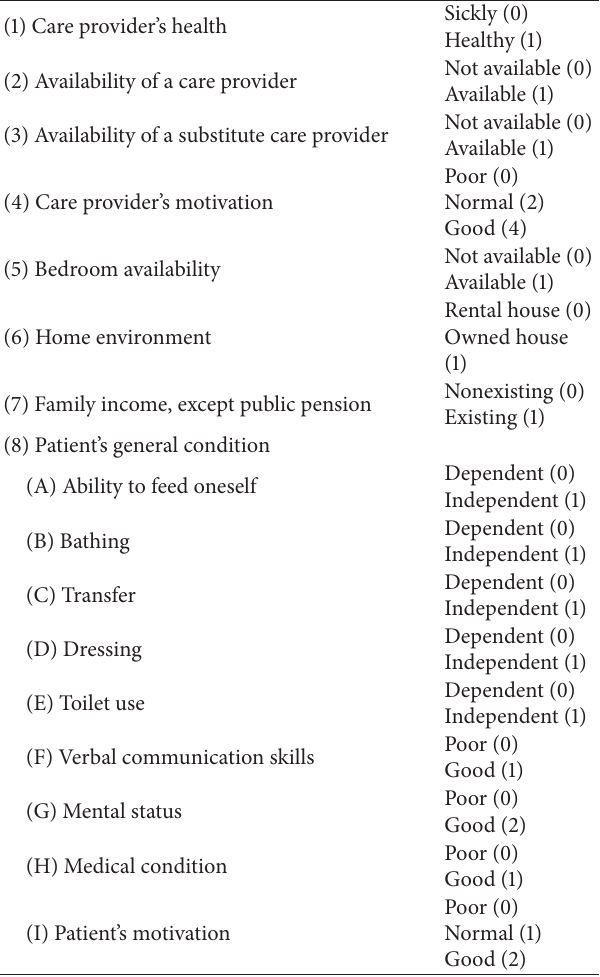
Table 3: Components of the home care